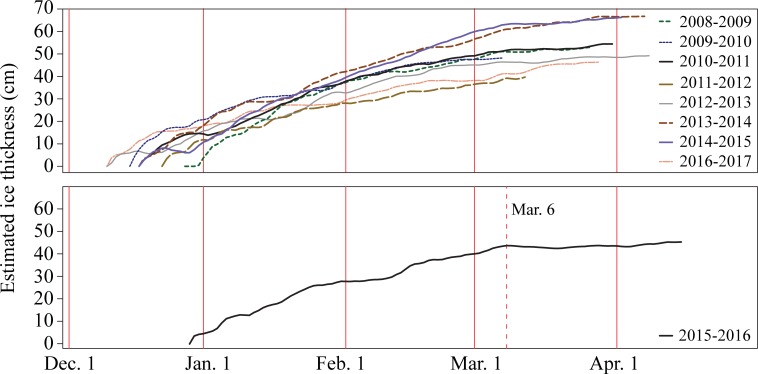
Yearly ice growth curves for the 2008–2009 to 2014–2015, and 2016–2017 ice seasons (top). Ice growth curve for the 2015–2016 ice season (bottom), which was separated to show the double AFDD peak, where the dotted red line represents the first AFDD maximum that was used to estimate ice thickness in the optimized model. The solid red lines represent the first of each month as indicated.